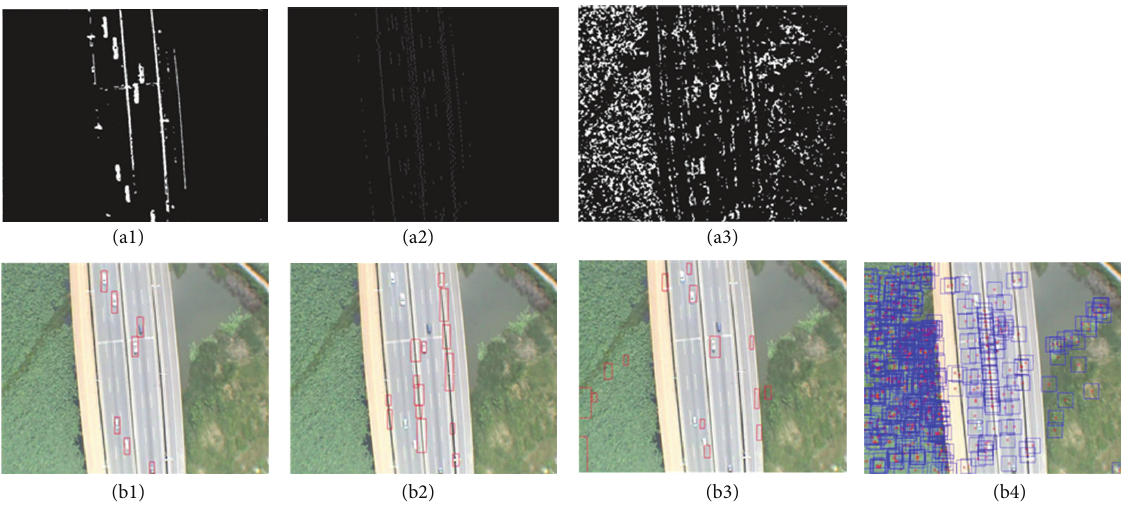
Figure 15: Vehicle detection results of GMM, LK, and proposed